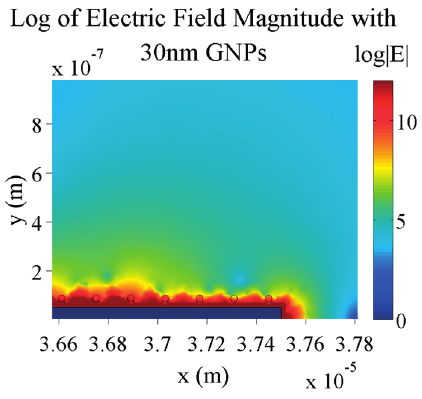
Figure 12. Simulation of the electric field magnitude of 5 µm digit and 2.5 µm gap electrodes with 0.1 V applied, 10 mM KCl concentration and 30 nm GNPs bound to the